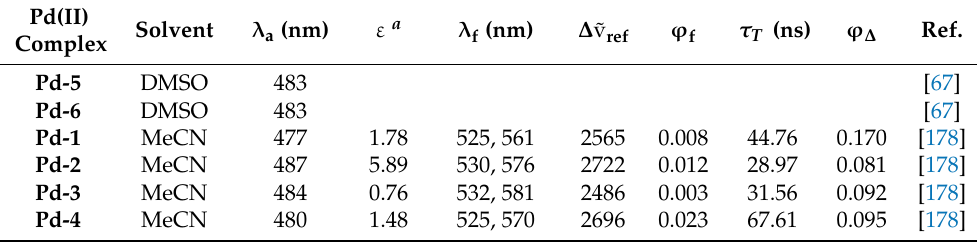
Table A3. Photophysical properties of several (dipyrrinato)Pd(II) complexes.